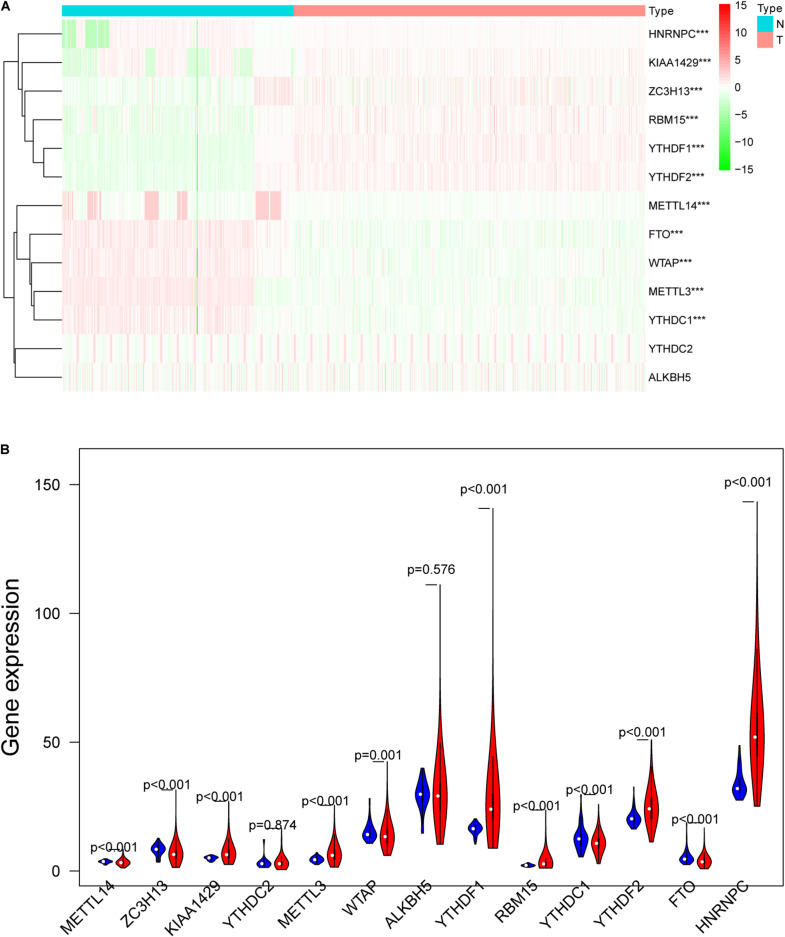
The differentially expressed m6A RNA methylation regulators between lung adenocarcinoma samples and normal control samples. (A) The heatmap was used to visualize the differential expression levels of m6A RNA methylation regulators between the cancer group and control group. (B) The violin plot was used to present the differential expression levels of m6A RNA methylation regulators between the cancer group and control group. N, normal samples; T, tumor samples; blue violins represent normal samples; red violins represent tumor sample; *P < 0.05, **P < 0.01, ***P < 0.001.